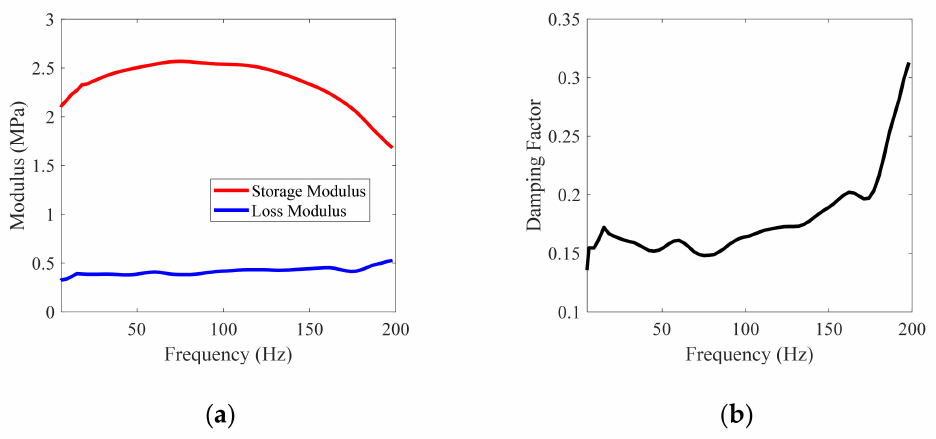
Figure 7. Material viscoelastic test results: ( a ) Storage modulus and loss modulus; ( b ) Damping